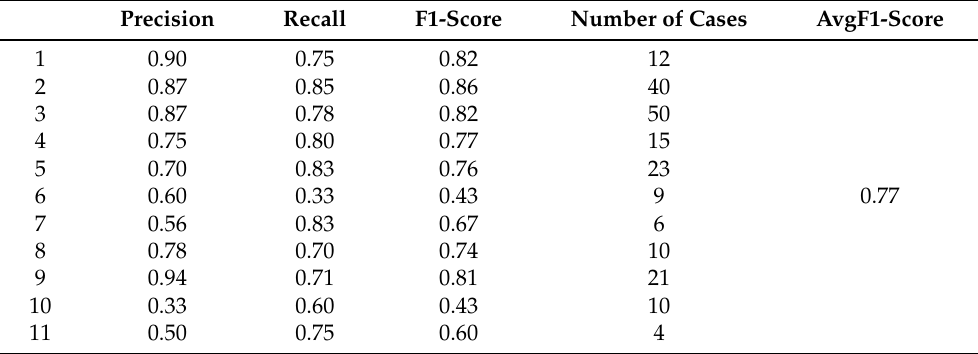
Table 5. Results of the comparison experiment and the ablation experiment. Average Precision Average Recall AvgF1-Score Decision trees